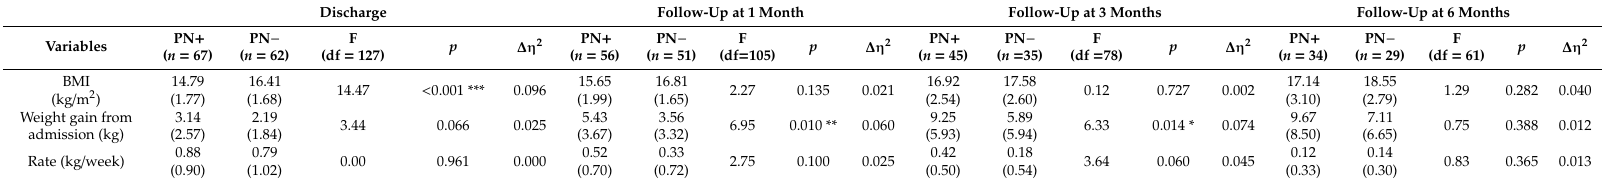
Table 4. Weight outcomes of AN patients with and without PN at discharge and follow-up after discharge.